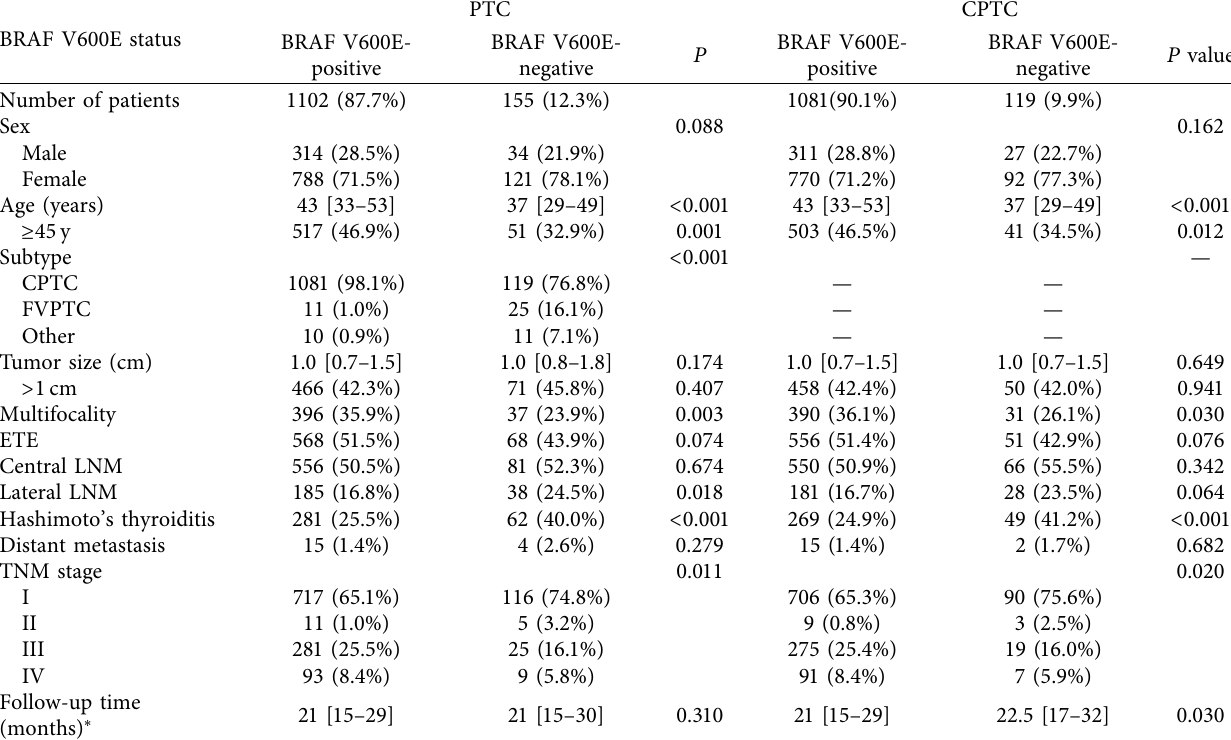
Table 1: Demographic and clinicopathological characteristics of PTC and CPTC